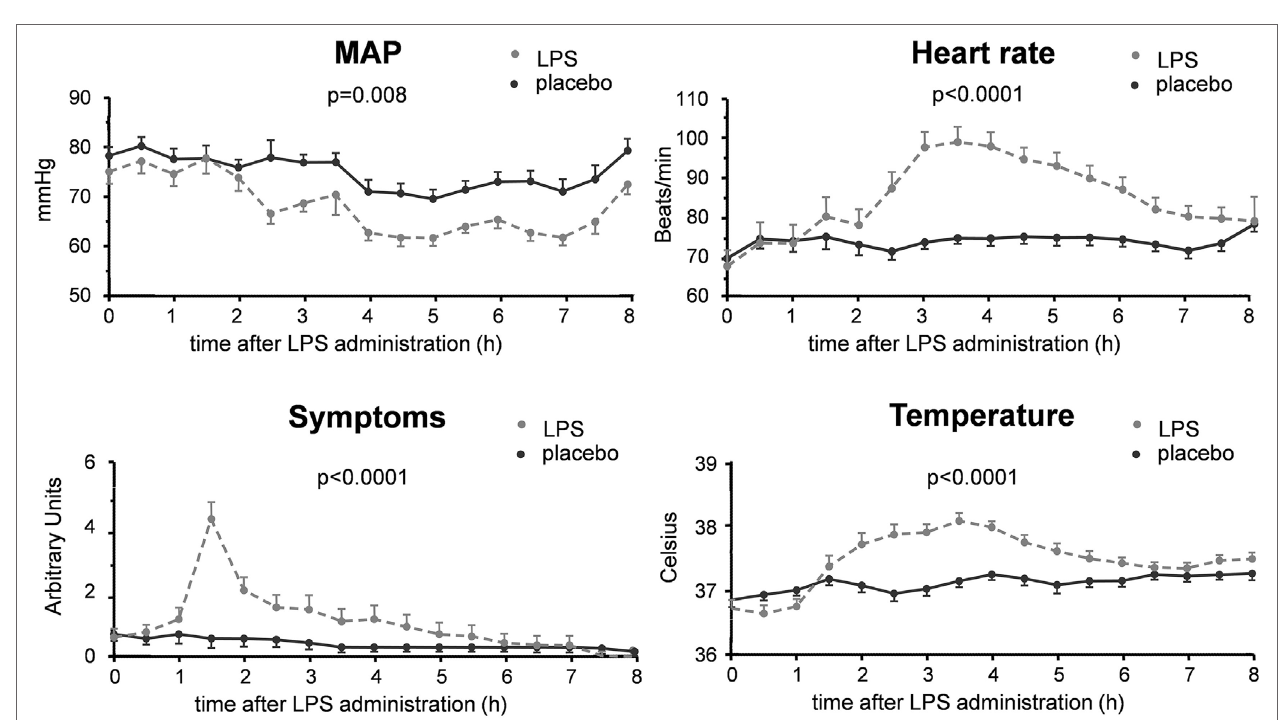
FigUre 4 | Circulating leukocyte numbers in 30 subjects who received an intravenous administration of lipopolysaccharide (LPS) ( n = 15) or placebo ( n = 15) at T = 0. Data are represented as mean ± SEM.